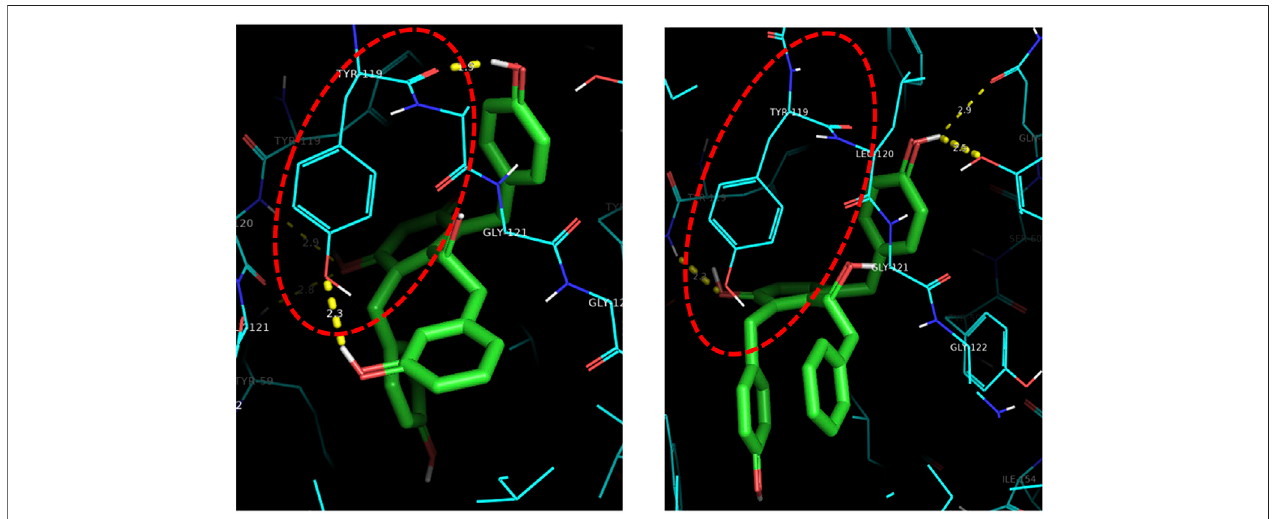
FIGURE 7 | Three-dimensional molecular docking model of compounds 2 and 3. Detail of the compound-binding pocket within the TNF homotrimer, with key residues involved in binding highlighted.